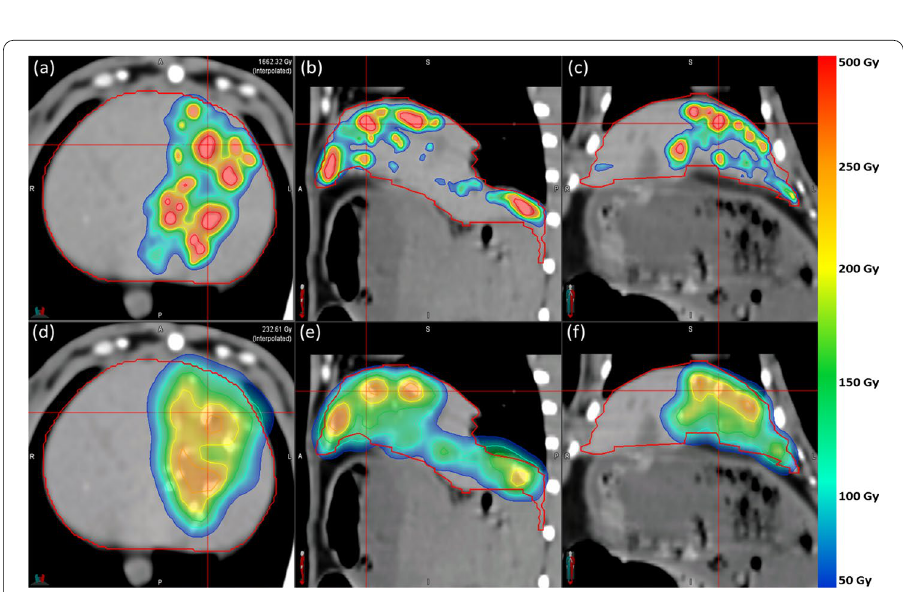
Fig. 10 a – c Axial, sagittal, and coronal views of the CT-based dose distribution DD CT in R06 overlaid on an axial CT [-100 to 200 HU]. d – f Axial, sagittal, and coronal views of the PET-based dose distribution DD PET in R06 overlaid on an axial CT [ 100 to 200 −